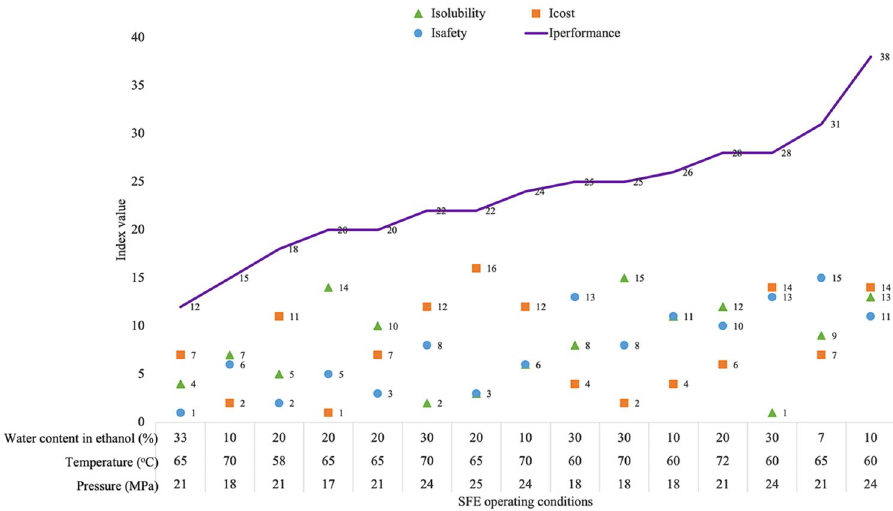
Figure 6. Overall performance index, I performance, for SFE G. procumbens.